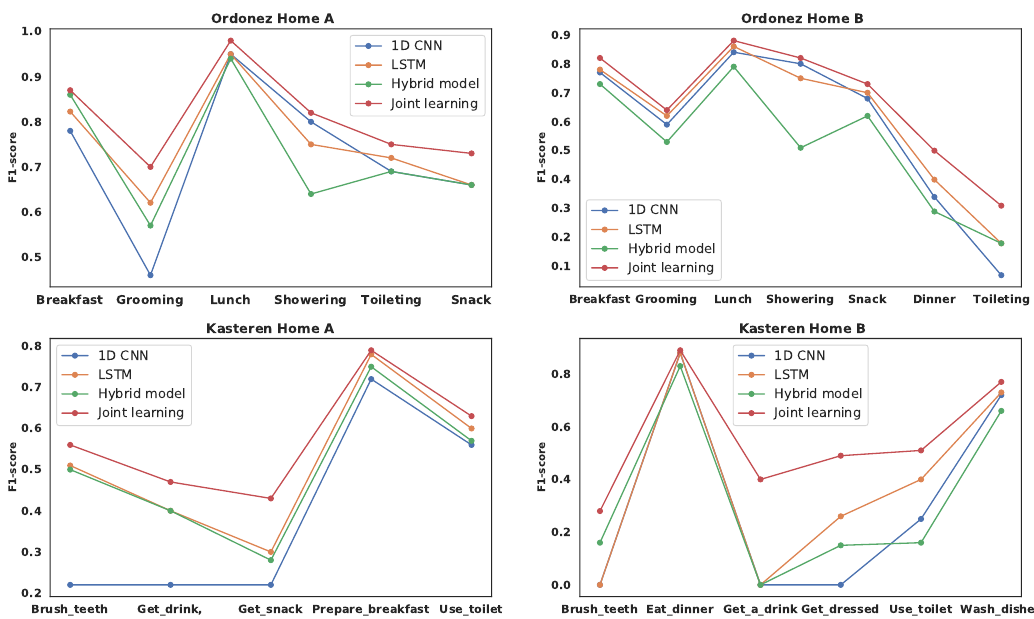
Figure 8. F1-score results of only minority